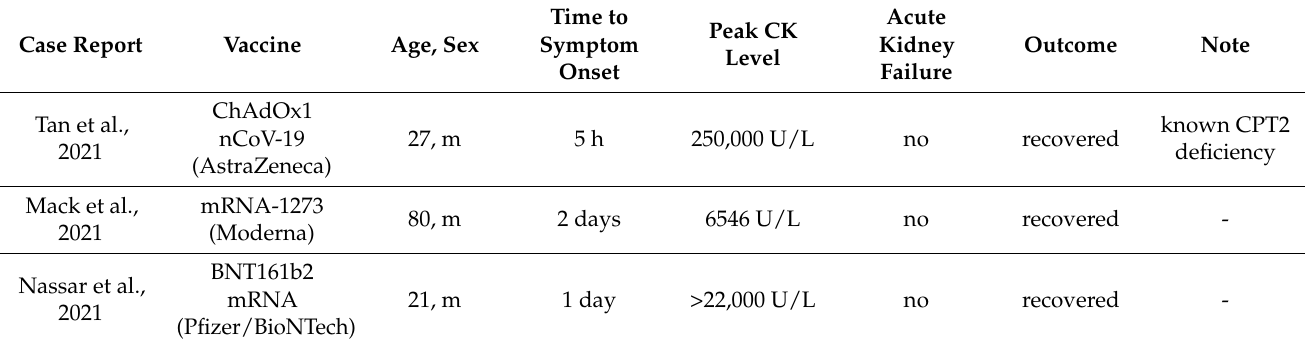
Table 2. Summary of published cases of rhabdomyolysis associated with COVID-19 vaccinations.